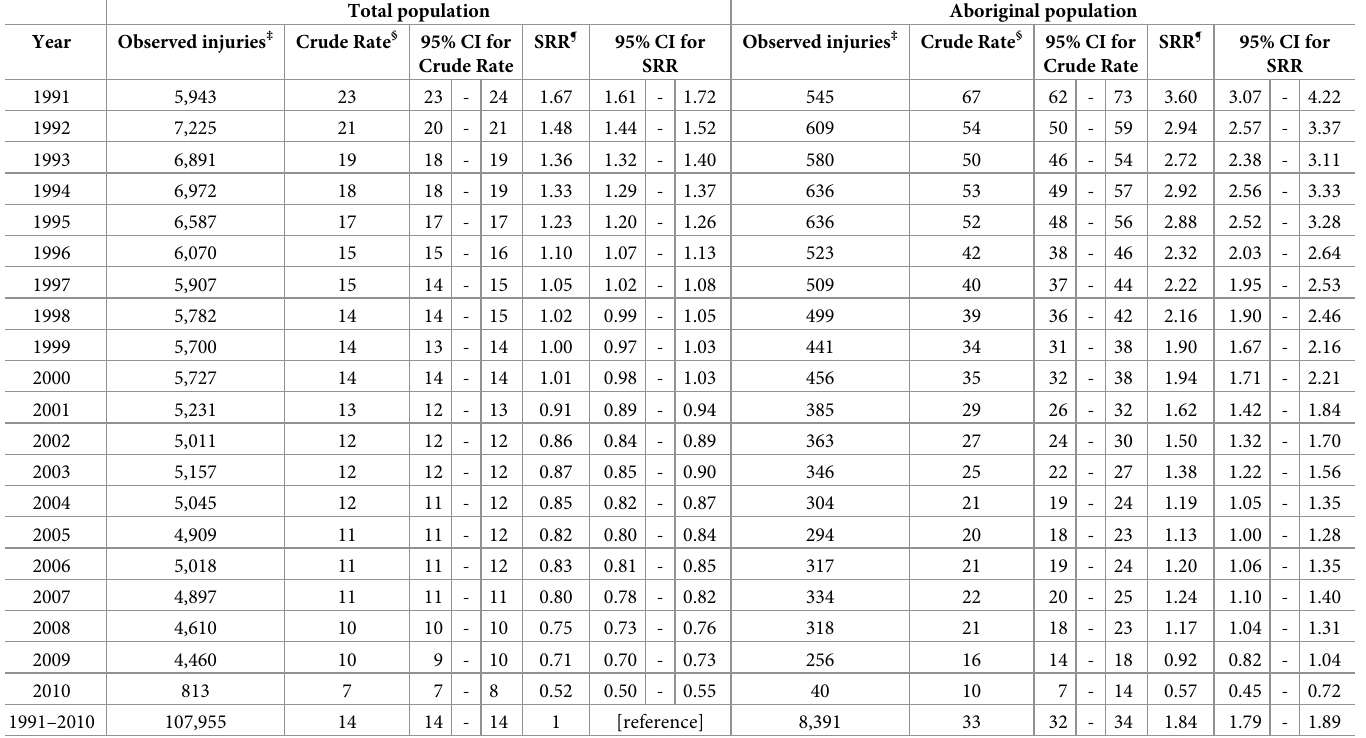
Table 4. Hospital separations for unintentional transport injuries (cid:3) , British Columbia, 1991–2010†, by calendar year. Observed injuries ‡ Crude Rate § 95% CI